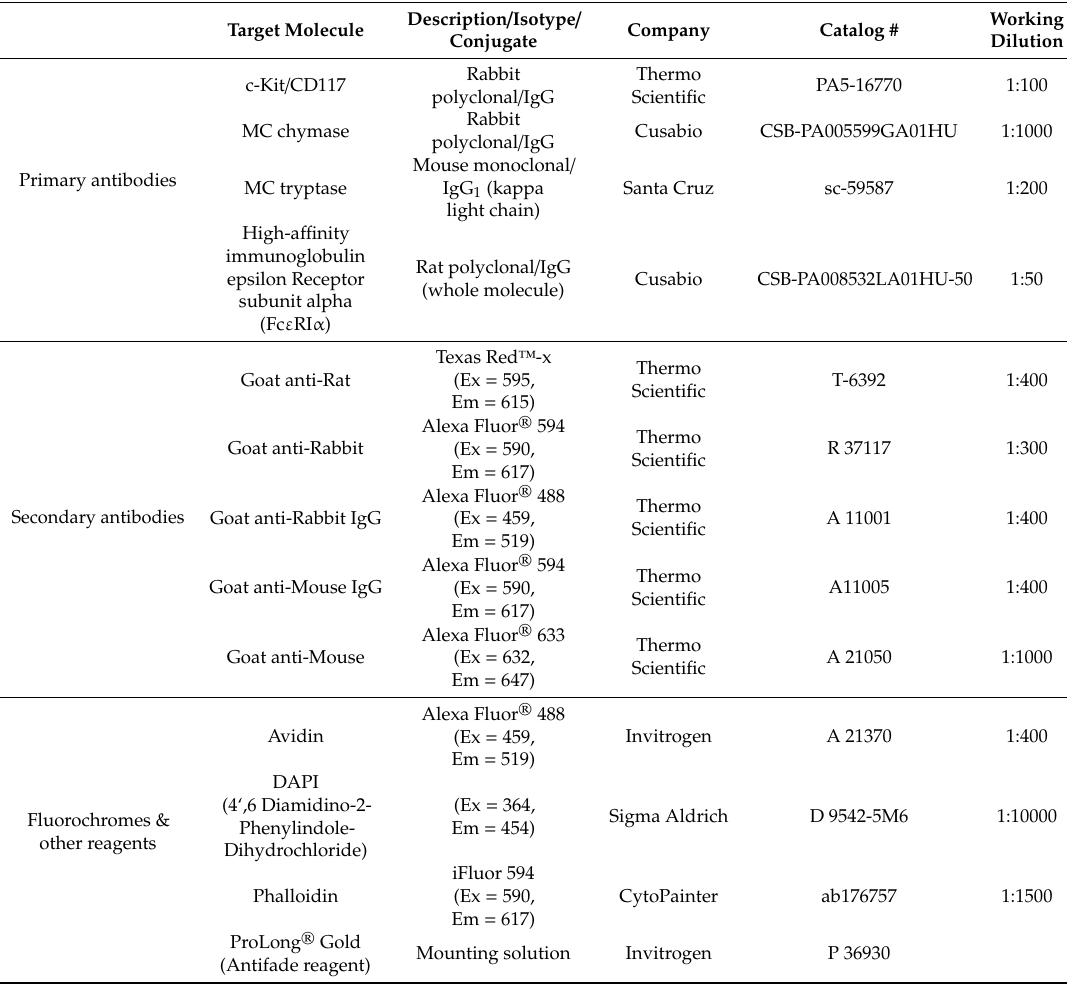
Table 1. Primary and secondary antibodies and